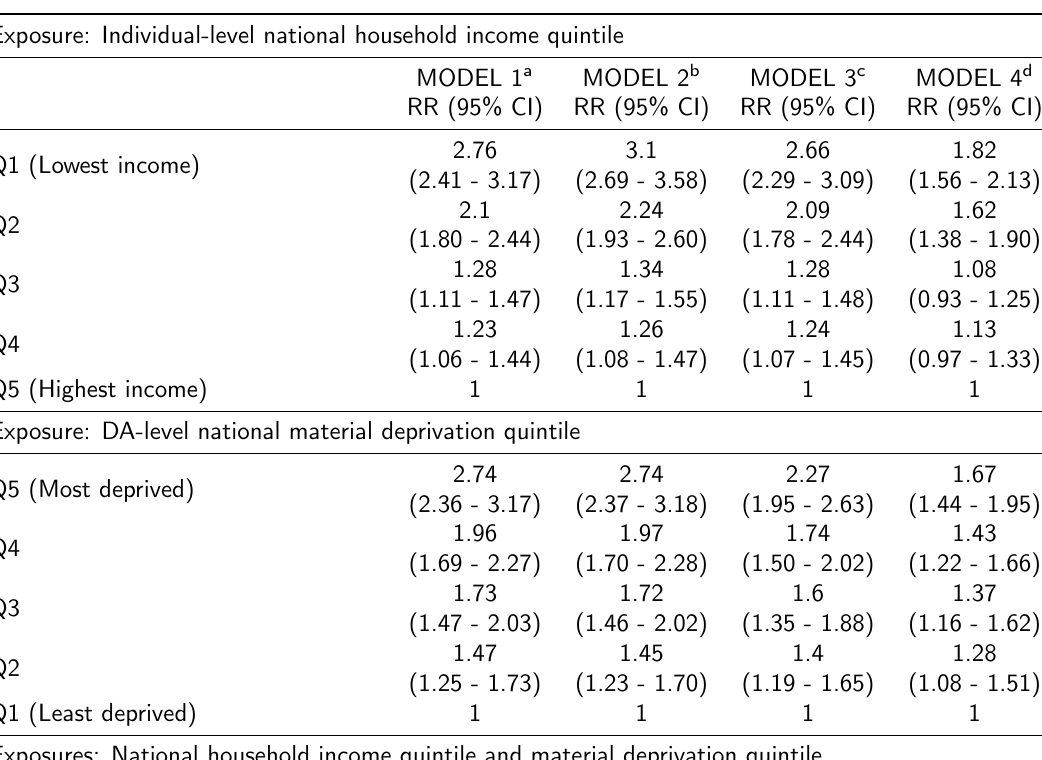
Table 2: Multivariable Sequentially Adjusted Modified Poisson Regression Models with Robust Error Variance for Individual-Level National Household Income Quintile, DA-Level National Material Deprivation Quintile, and Index Prospective ACSC Hospitalization for Pooled CCHS Respondents (Cycles 2000/2001-2011) (N=